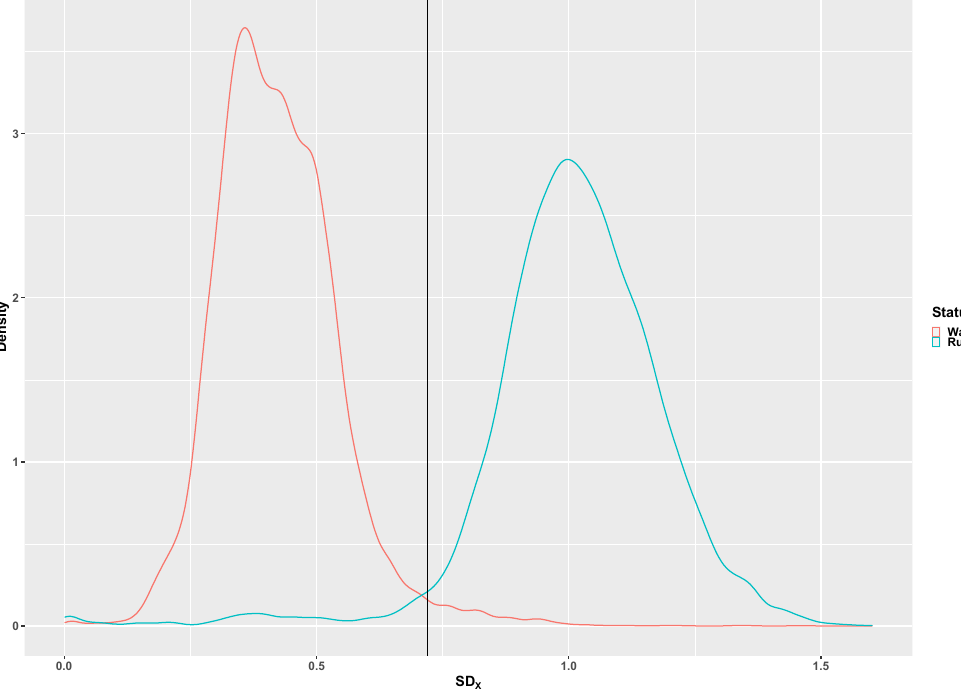
Figure 4. The pooled distribution of the SD X signal feature for walking (red curve) and running (green curve). The vertical line represents the original adult 0.72 g SD X threshold (Skotte et al. 2014).